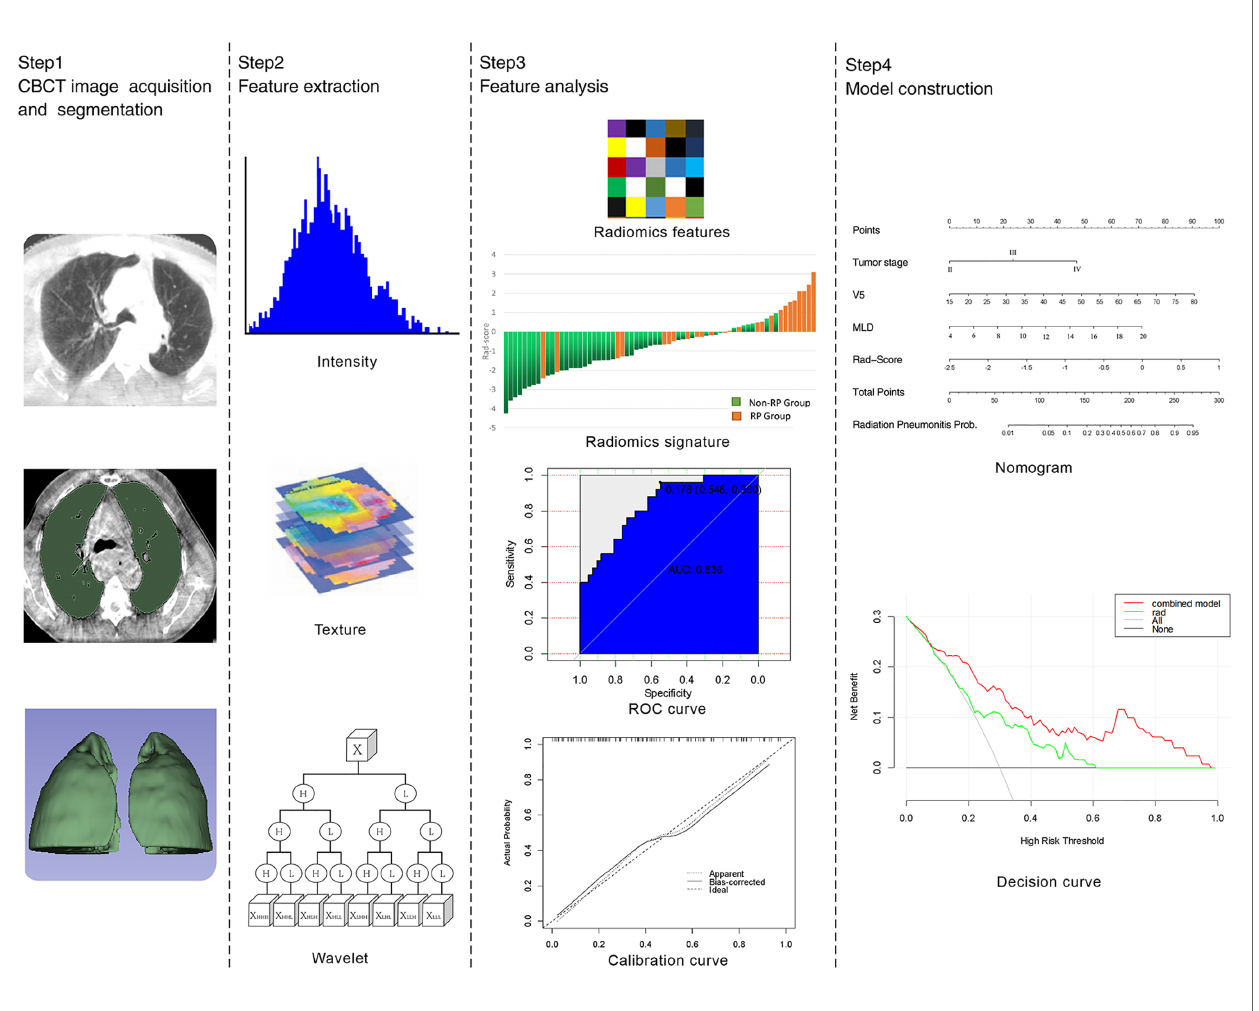
FIGURE 1 | Flow chart of